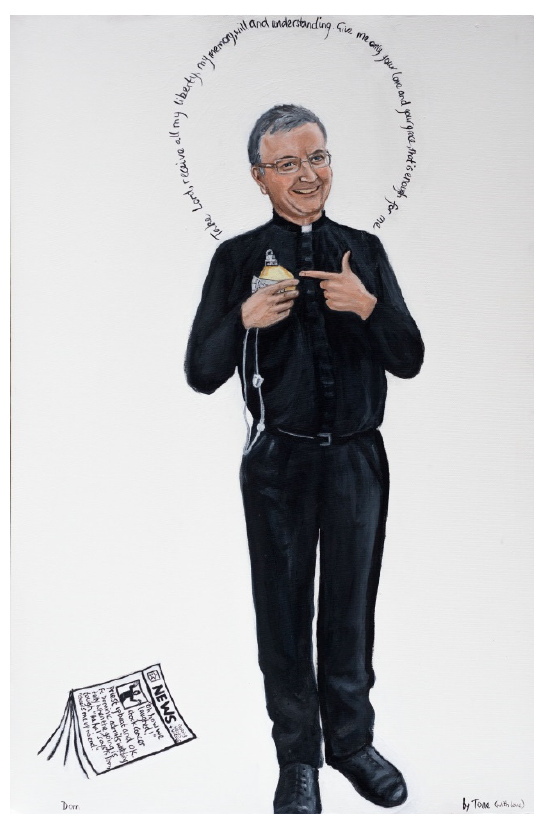
Figure 9. Fr Dominic